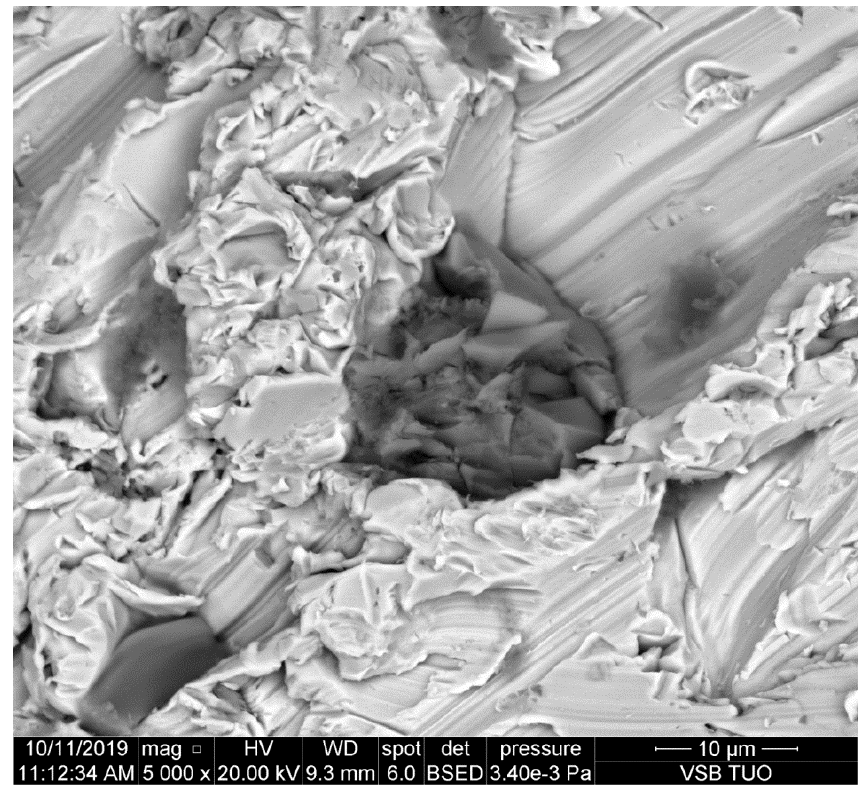
Figure 4. The abrasive particle pressed into the cutting wall of the common construction steel.